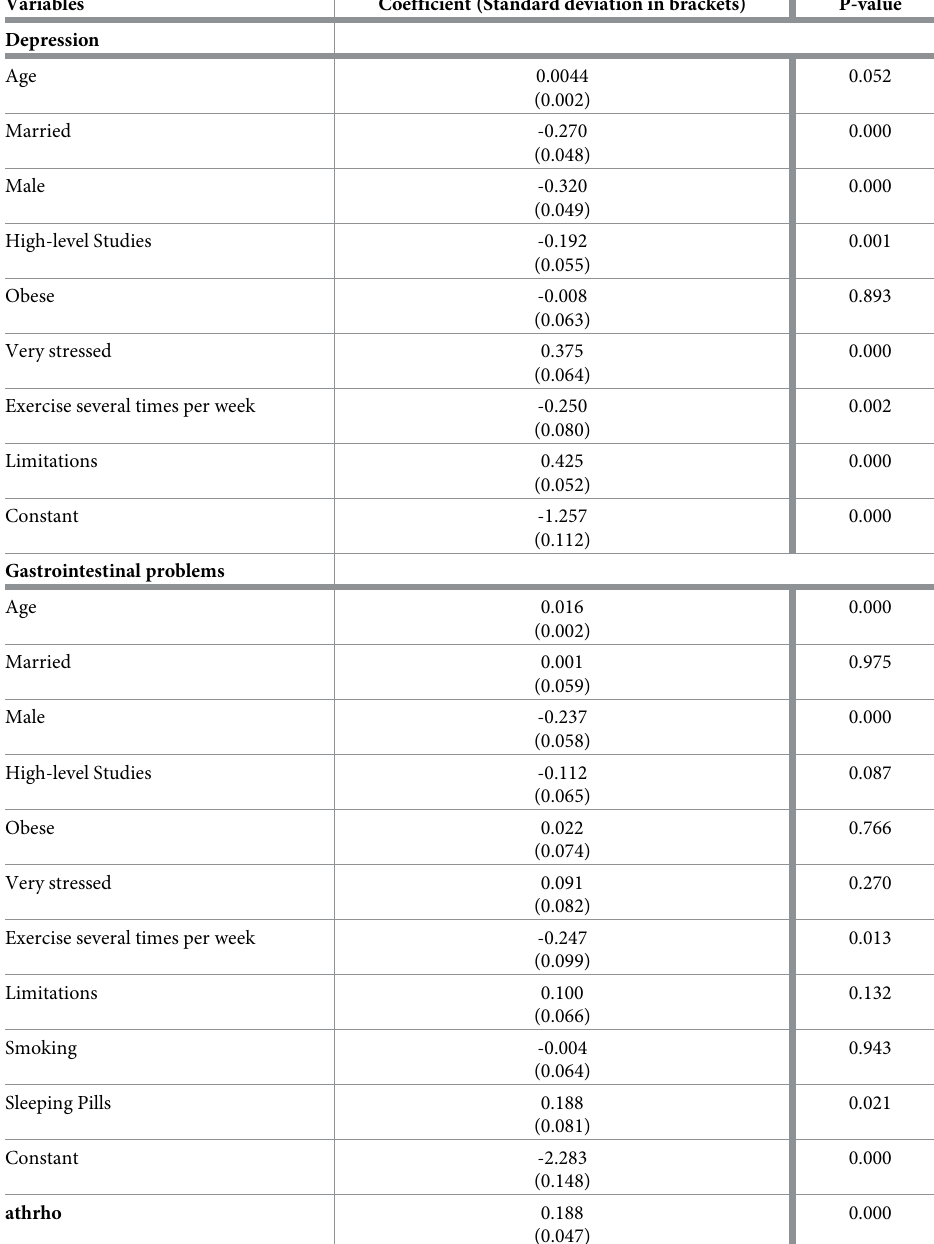
Table 4. Bivariate probit of having anxiety and having gastrointestinal problems.